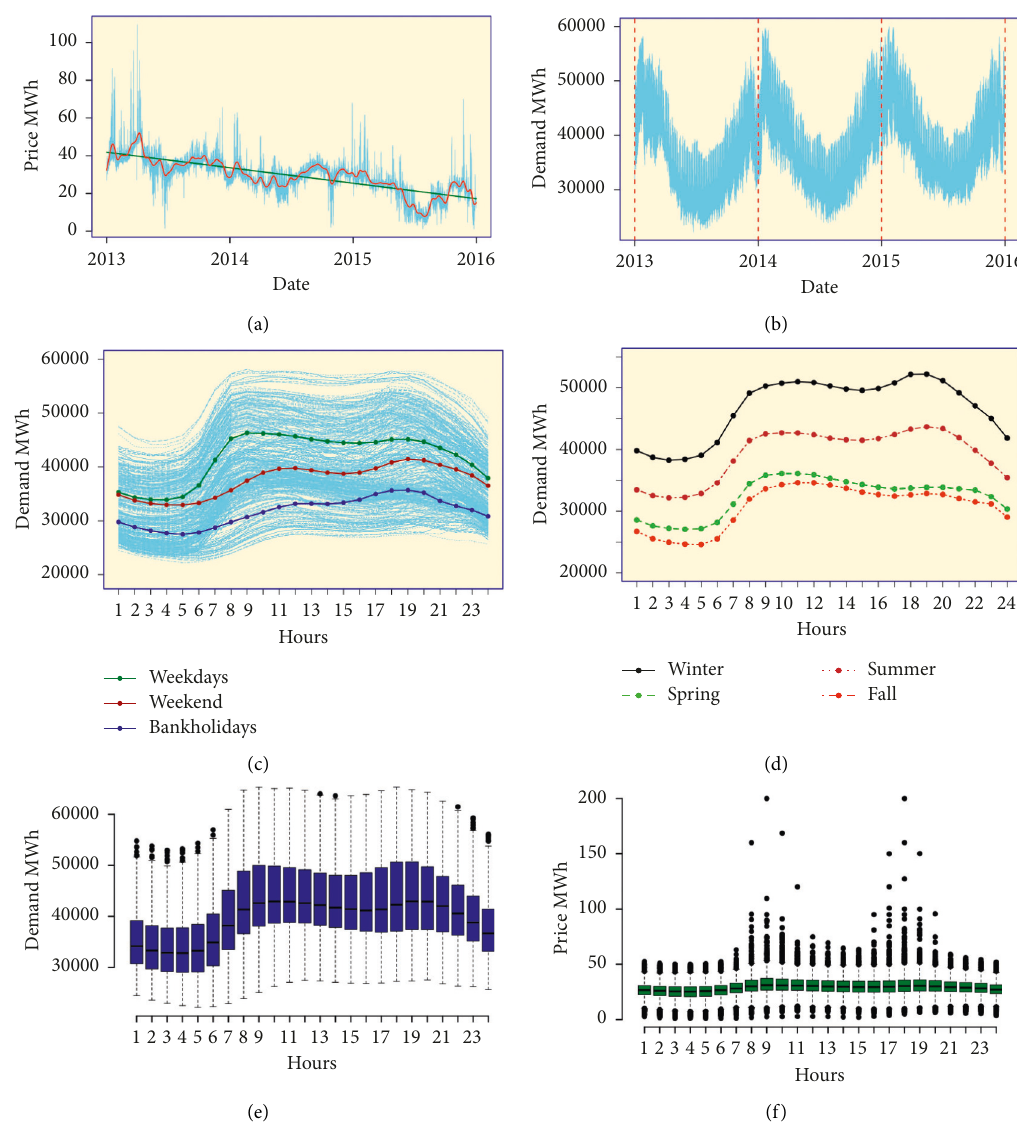
Figure 1: Specific features of electricity demand and price for the period January 1, 2013, to December 31, 2016 (a) prices series with superimposed linear (dark-green) and a nonlinear (red) trend, (b) demand annual seasonality, (c) average weekly and bank holidays curves, (d) average seasonal curves, (e) hourly demand, and (f) hourly prices box